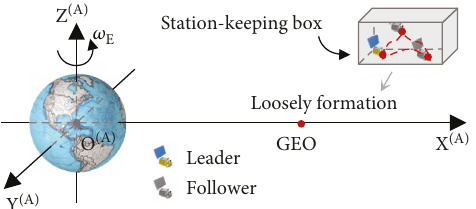
Figure 7: Loosely formation in the rotating reference frame